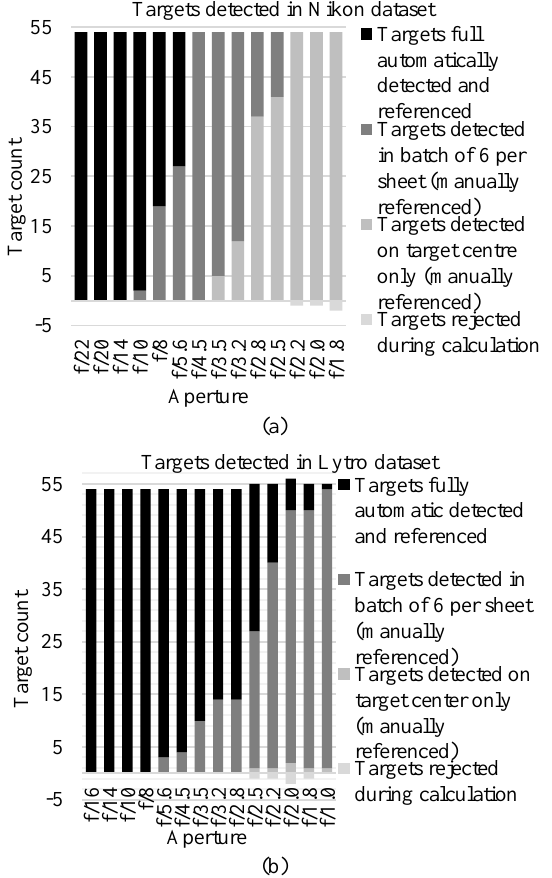
Table 3. Forensic Scene: Crosses measured in Lytro image sets.